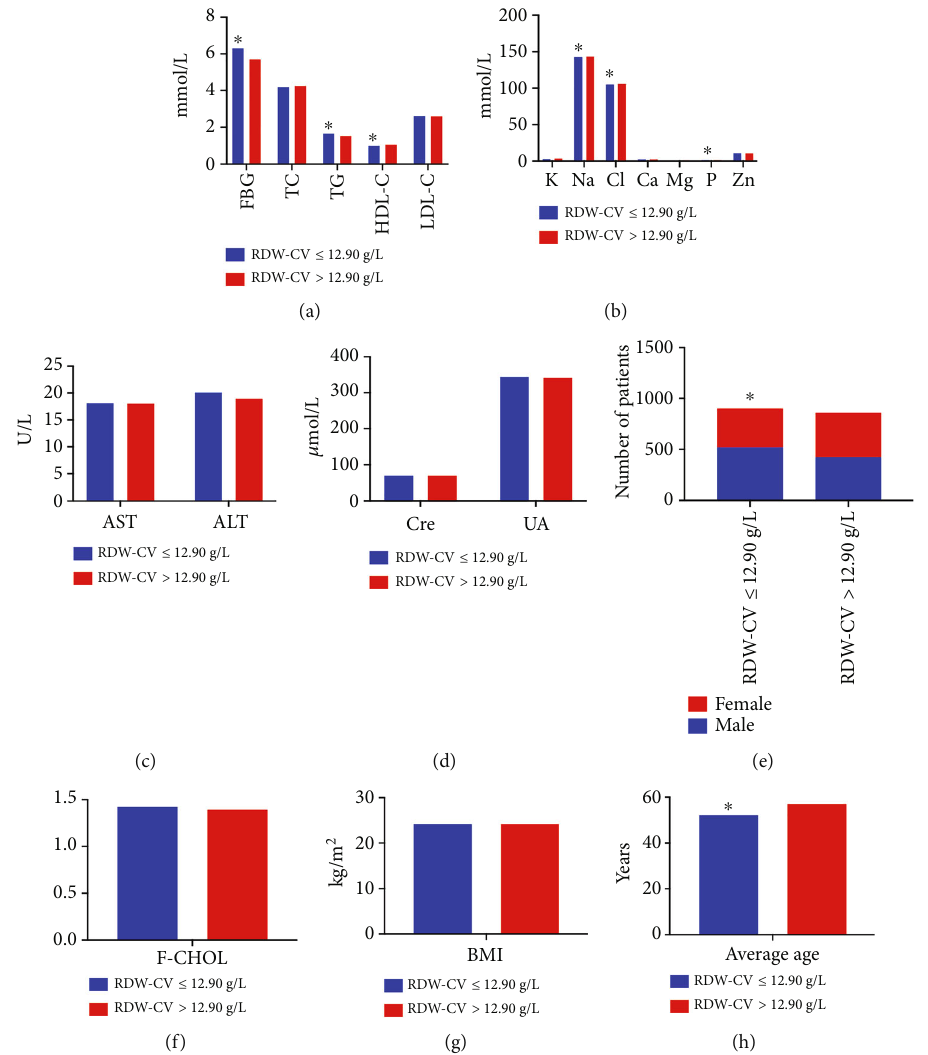
Figure 4: Comparison of di ff erent indicators between the RDW − CV ≤ 12 : 90 g/L and RDW − CV > 12 : 90g/L groups. (a) Comparison of levels of FBG, TC, TG, HDL-C, and LDL-C between the two groups. Compared with the RDW − CV > 12 : 90g/L group, the levels of FBG and TG were signi fi cantly higher but levels of HDL-C were lower in RDW − CV ≤ 12 : 90 g/L group. (b) Comparison of levels of K, Na, Cl, Ca, Mg, P, and Zn in the blood between the two groups. The levels of blood Na, Cl, and P were signi fi cantly lower in the RDW − CV ≤ 12 : 90g/L group than that in the RDW − CV > 12 : 90g/L group. (c) Comparison of AST and ALT levels between the groups. (d) Comparison of Cre and UA levels between the groups. (e) Comparison of the number of male and female patients between the groups. (f) Comparison of levels of F-CHOL between the groups. (g) Comparison of BMI of patients between the groups. (h) The average age of patients in RDW − CV ≤ 12 : 90g/L group was signi fi cantly higher than in RDW − CV > 12 : 90 g/L